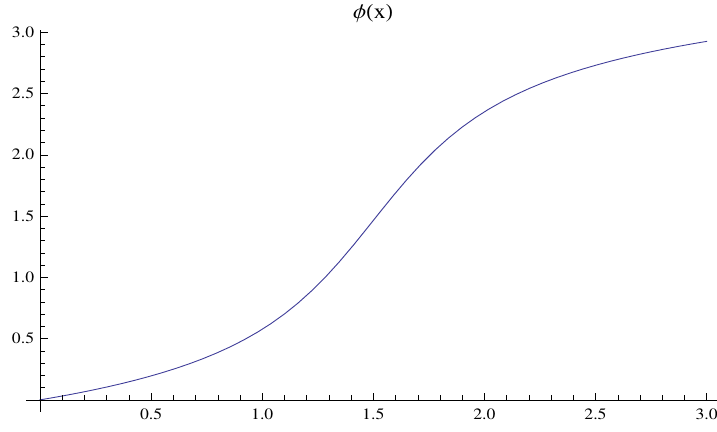
Figure A2. Plot of ϕ in a symmetric solution with ∆ ϕ (cid:39) 2.9, L =